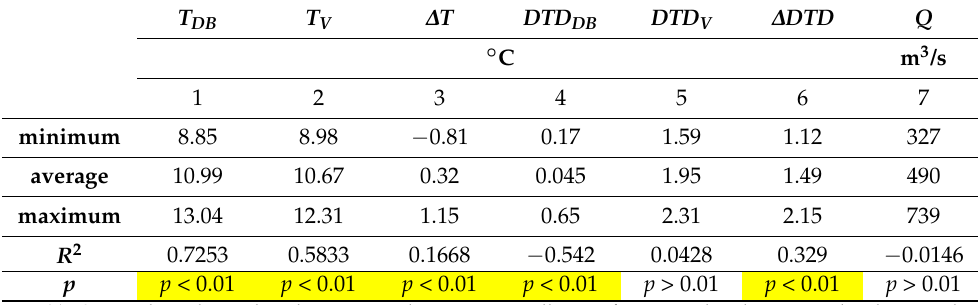
Table 3. Characteristic (minimum, average, maximum) annual values, squares of linear correlation coefficient of series, R 2 , probabilities of the Mann–Kendall test, p , series of yearly water temperatures of the Drava near Botovo, T DB , series of air temperature GMP Varaždin, T V , series of their differences, Δ T = T DB − T V , series of Day-to-Day water temperature of the Drava near Botovo, DTD DB , series of Day-to-Day air temperature of GMP Varaždin, DTD V , series of their differences, Δ D TD = ( DTD V − DTD DB ), series of mean flows of the Drava near Botovo, Q , in the period 1969–2021.